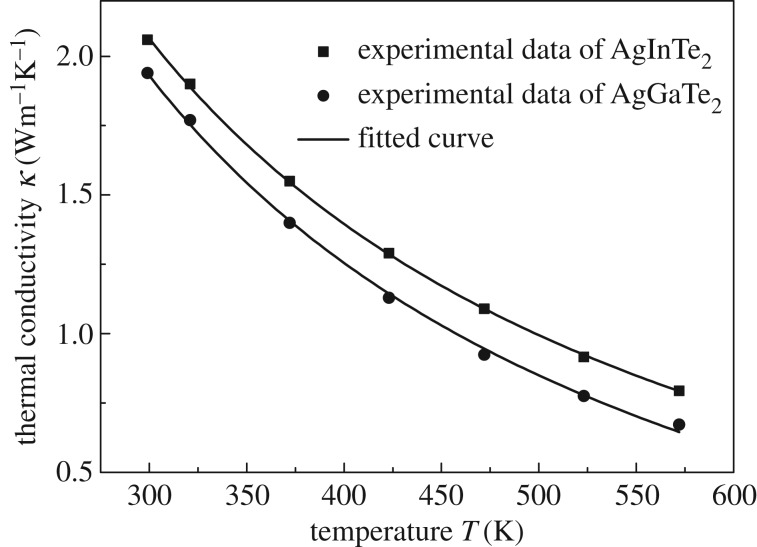
Fitted thermal conductivity curves for AgInTe2 and AgGaTe2 compounds.